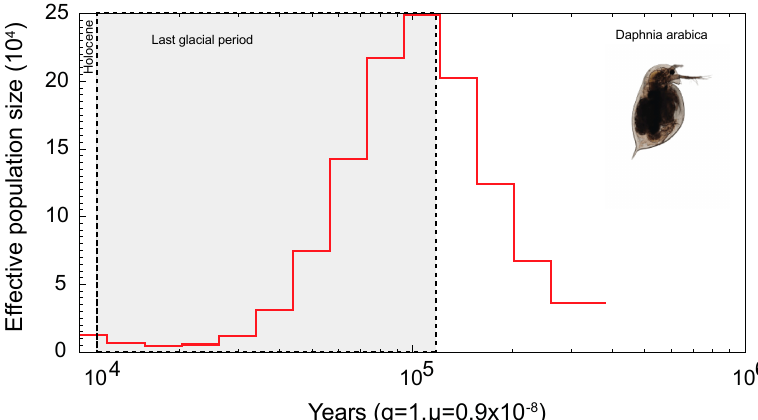
Figure 5. D. arabica effective population size reduction estimation.